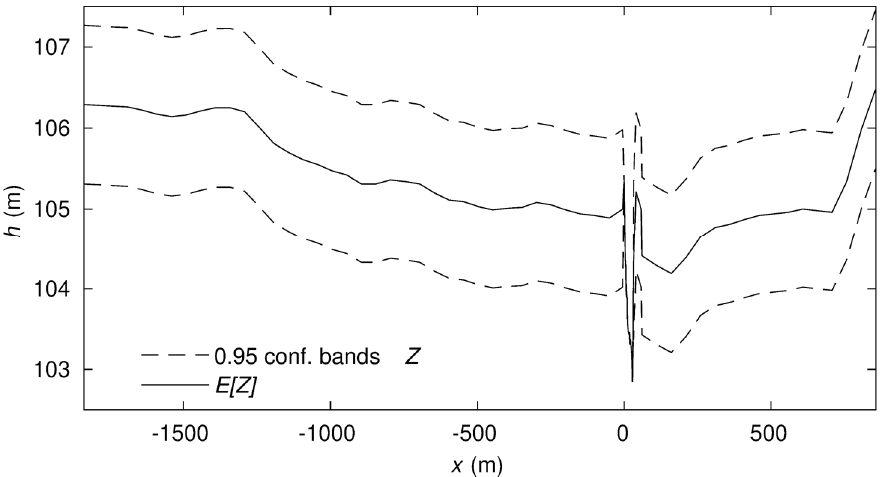
Figure 2. Cross section next the measurement point with elevation uncertainty; x denotes cross section width; h elevation a.s.l.